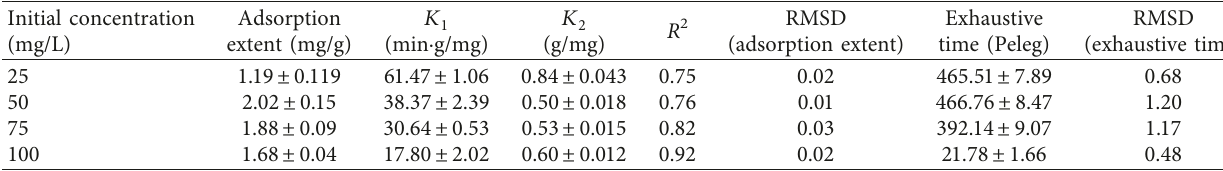
Table 4: Values of adsorption extent, Peleg’s constants ( K mean squared deviation (RMSD) at different initial concentrations.